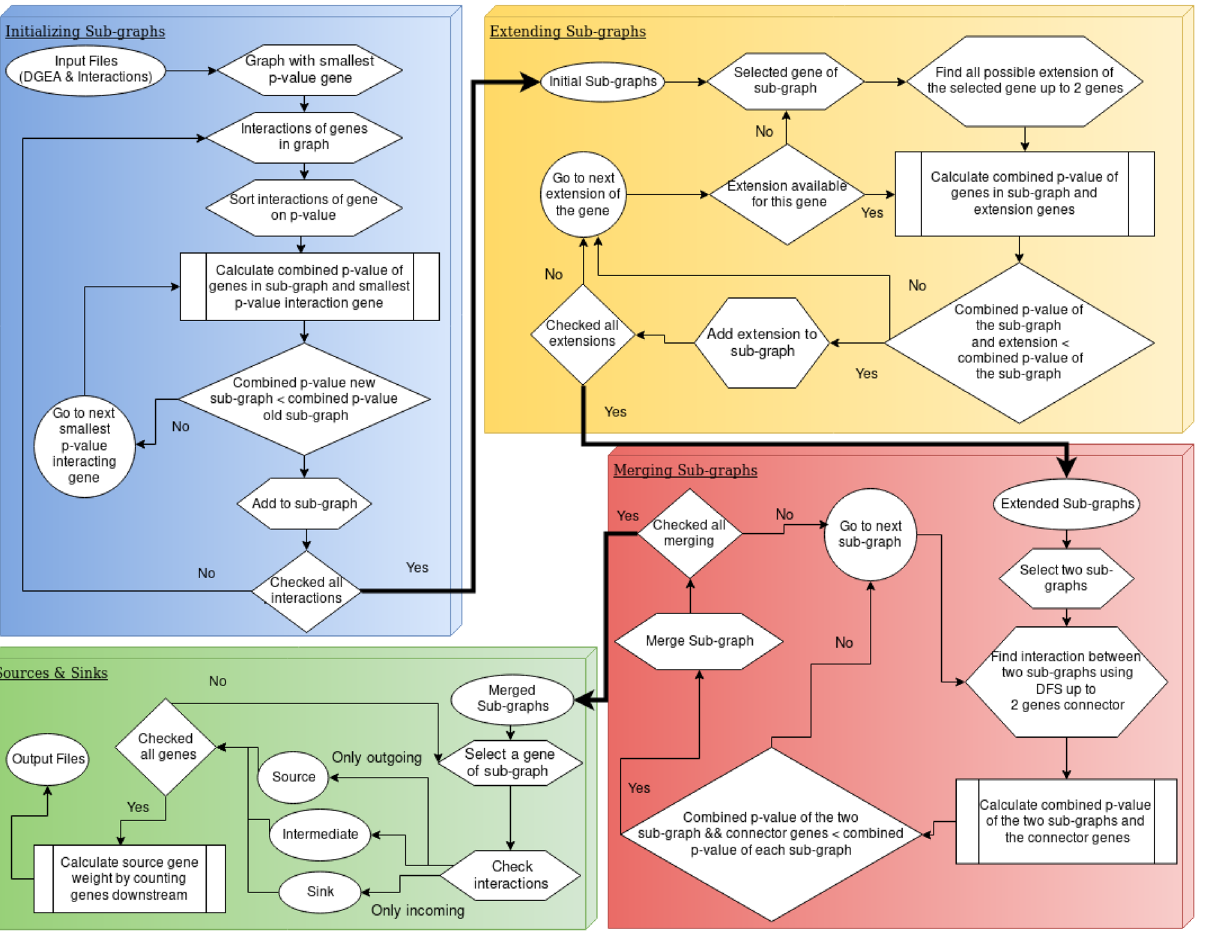
Figure 1. Graphical representation of the MSF heuristic approach to detect modulated sub-graphs in a global gene regulatory